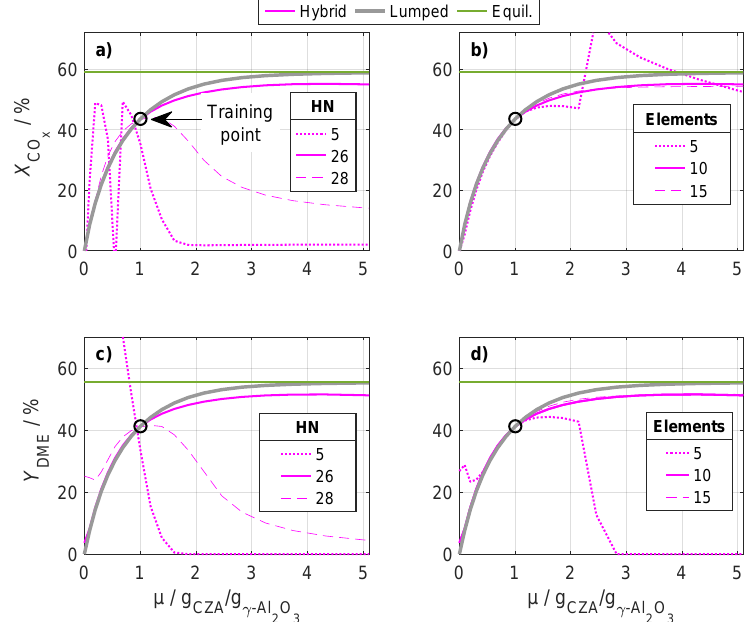
Figure 10. Dimension extrapolation of the catalyst bed composition.The plots show ( a ) the CO x conversion calculated with the lumped model and with the hybrid models consisting of various HN, ( b ) the CO x conversion at various mesh refinements, ( c ) the DME yield calculated with the lumped model and hybrid models consisting of various HN as well as ( d ) the DME yield at different mesh refinements. The results are plotted against µ , ranging from 0 to 5. Feed composition: 48.42% H 16.07% CO, 2.81% CO . Total gas flow 0.2 slpm. Temperature 533 K. Pressure 50 bar. 2